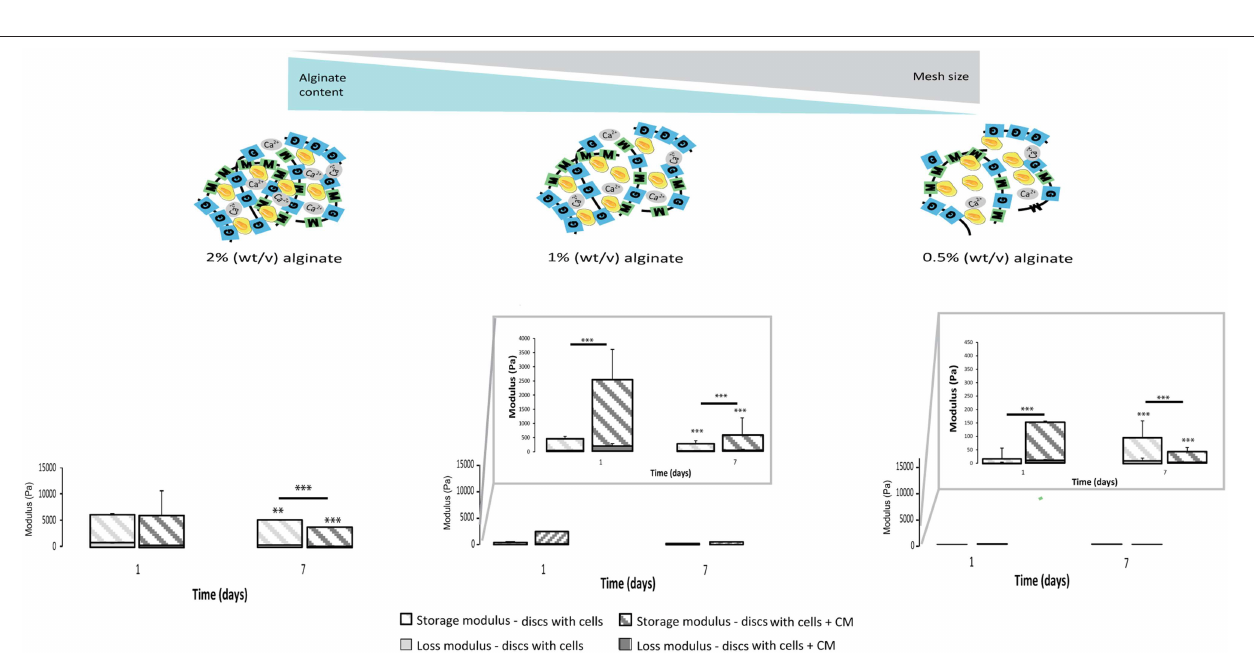
FIGURE 4 | Effect of control and CM treated astrocytes seeded in 3D alginate discs on cortical neurons. Results are shown as mean ± standard deviation; asterisks represent statistical differences *** p < 0.001 (A) Experimental set-up. Astrocytes were cultured for 4 days with fresh medium or conditioned medium. Neurons were cultured on glass cover-slips in 24 well-plates, alginate discs were placed on top of neurons using transwells; (B) (Left) Effect of astrocytes on axonal outgrowth ( n = 95 cells); (right) immunocytochemistry of cultured cortical neurons with anti-TAU, at the day of image analysis, scale bar 100 µ m.